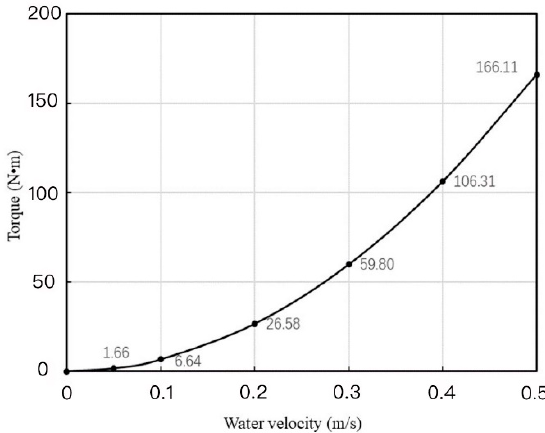
Figure 6. Ocean current turbine torque at different flow rates.